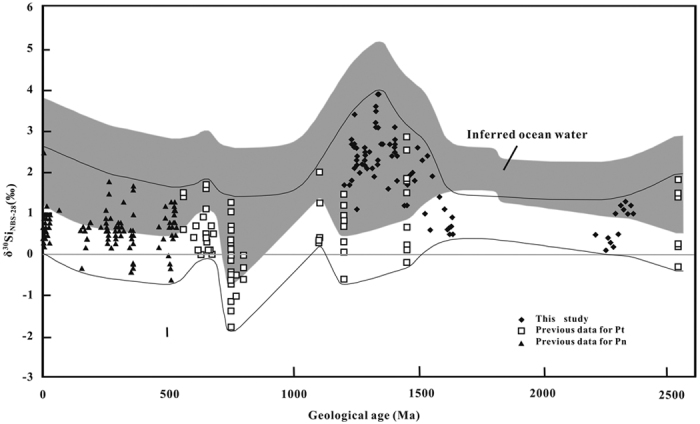
A plot showing δ30Si variations of chert formed in a shallow marine environment, and inferred ocean water, from the late Archean to the present.Previous data for Proterozoic chert (Pt)10242526 and Phanerozoic chert (Pn)22427282930 are included. Taking Δ30SiCh-SW to be −0.5‰, −1.0‰ and −1.2‰ in the Archean, early Proterozoic and since the middle Proterozoic, respectively, δ30SiSW values are calculated from δ30SiCh.